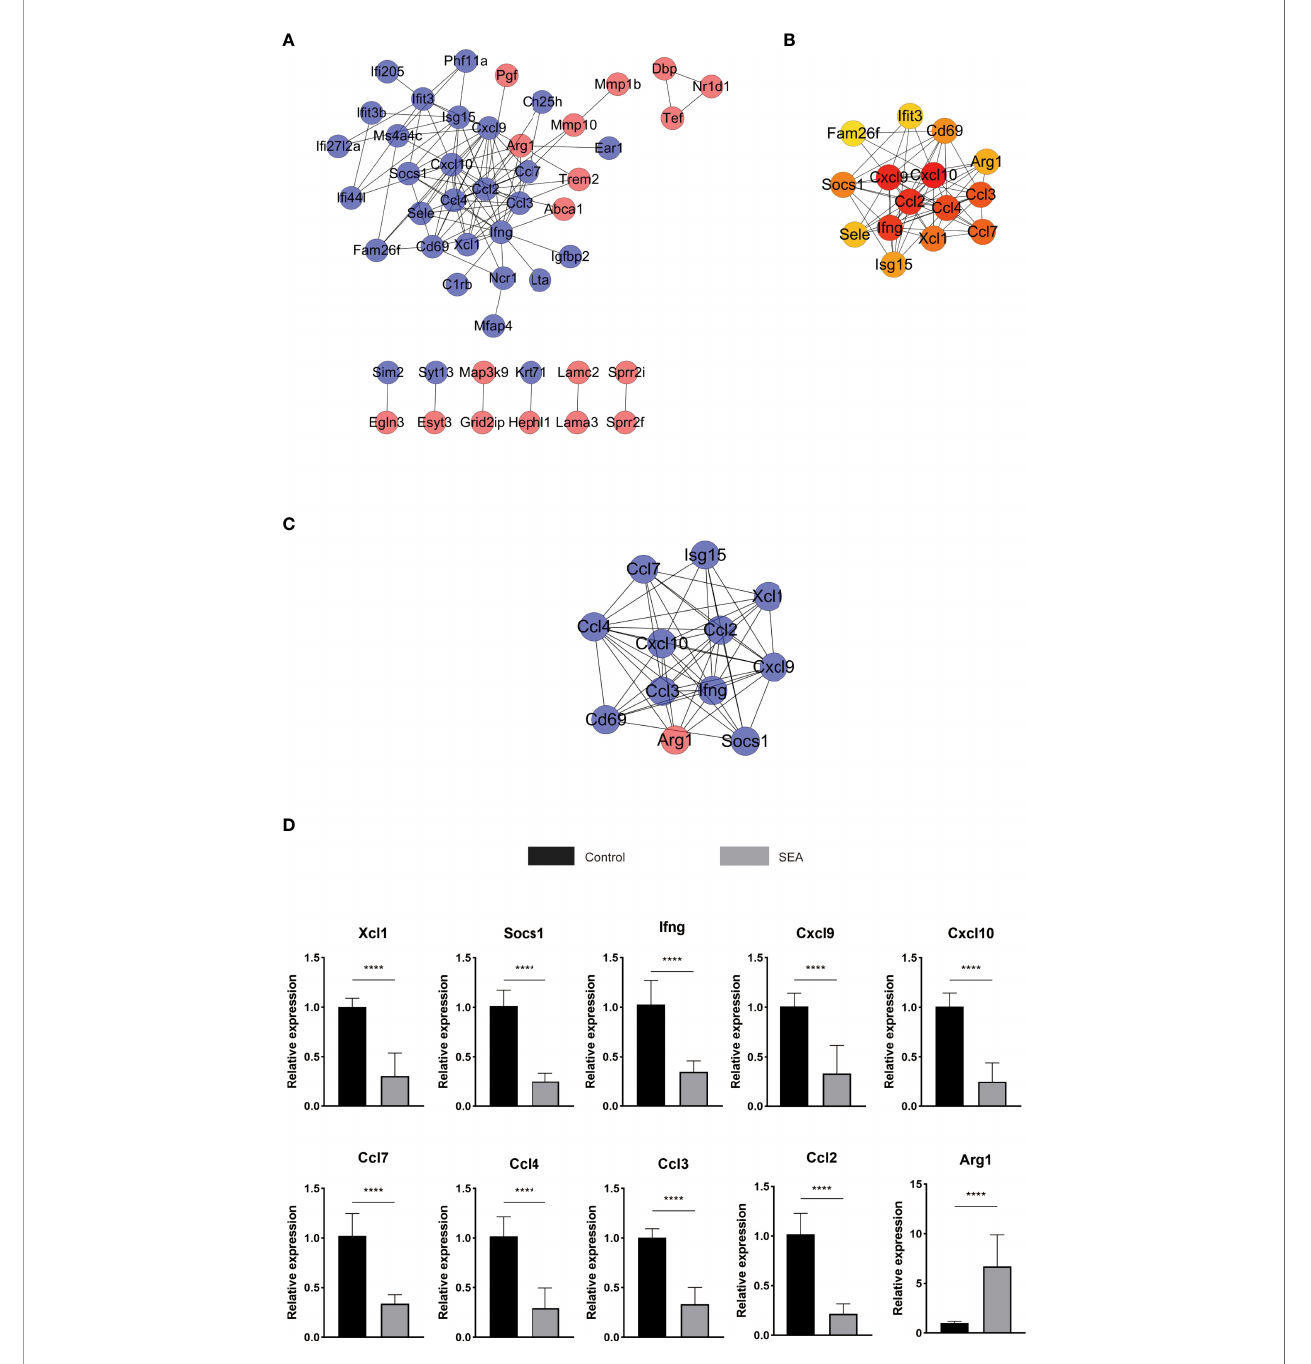
FIGURE 5 | PPI analysis and screening of the hub gene and key signaling pathways in DEGs. (A) STRING database analyzes DEGs to get 48 nodes and 106 edges displayed on Cytoscape. Red represents upregulated genes, blue represents downregulated genes, and orange represents hub genes. (B) Further analysis with cytoHubba obtained the top 15 most signi fi cant genes as hub genes. (C) MCODE analysis obtains 12 genes and 52 edges of module 1, MCODE 1 score: 9.455. (D) The hub gene of the skin graft obtained by RNA sequencing was veri fi ed by qPCR. The signi fi cance level was tested by unpaired t test ( n = 3 for each group). The data are shown as the mean ± SEM value. At least 3 independent experiments have also obtained similar results. * p < 0.05; ** p < 0.01; *** p < 0.001; **** p <